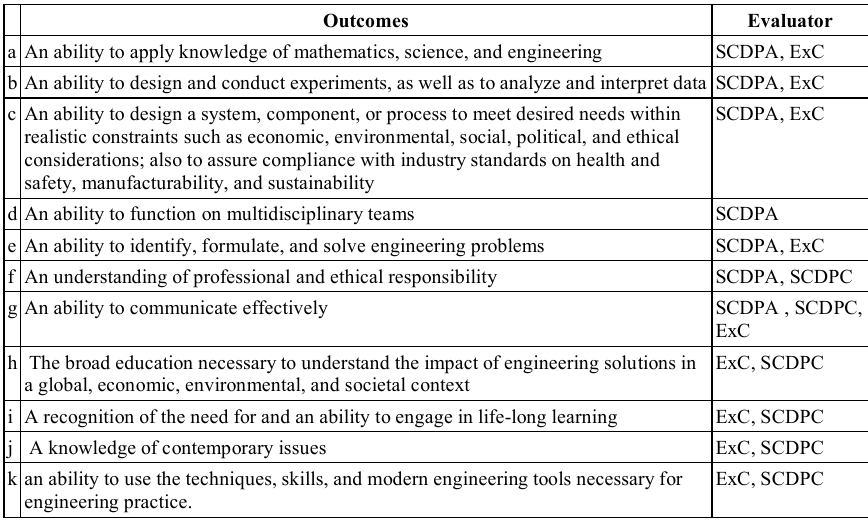
Table 4. ABET student outcomes for engineering [19]